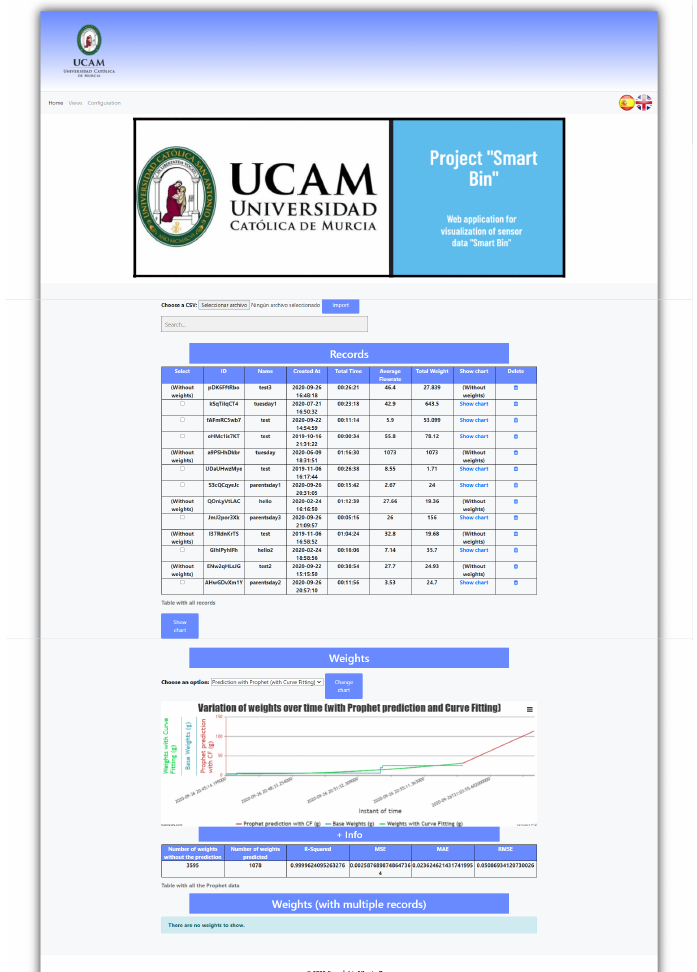
Figure 10. Main view of the web application. The upper section displays the list of experiments whereas the bottom one shows the time series of one of